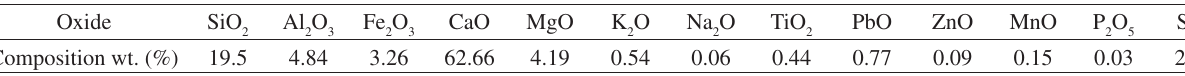
Table 1. Oxide composition of Portland cement.